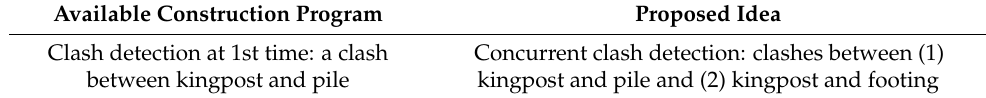
Table 1. An example of a comparison between available construction program and proposed idea. Available Construction Program